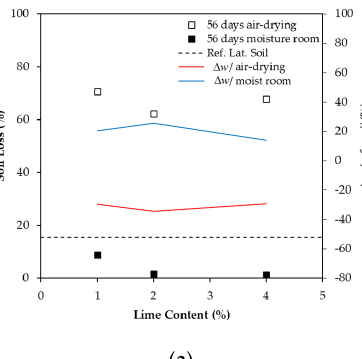
Figure 9. Percentage of soil mass loss versus lime content. Lateritic soil reference (Ref. Lat. Soil) = untreated soil; Δ w = water content variation; Sol.1% = 1% of lime saturated solution.